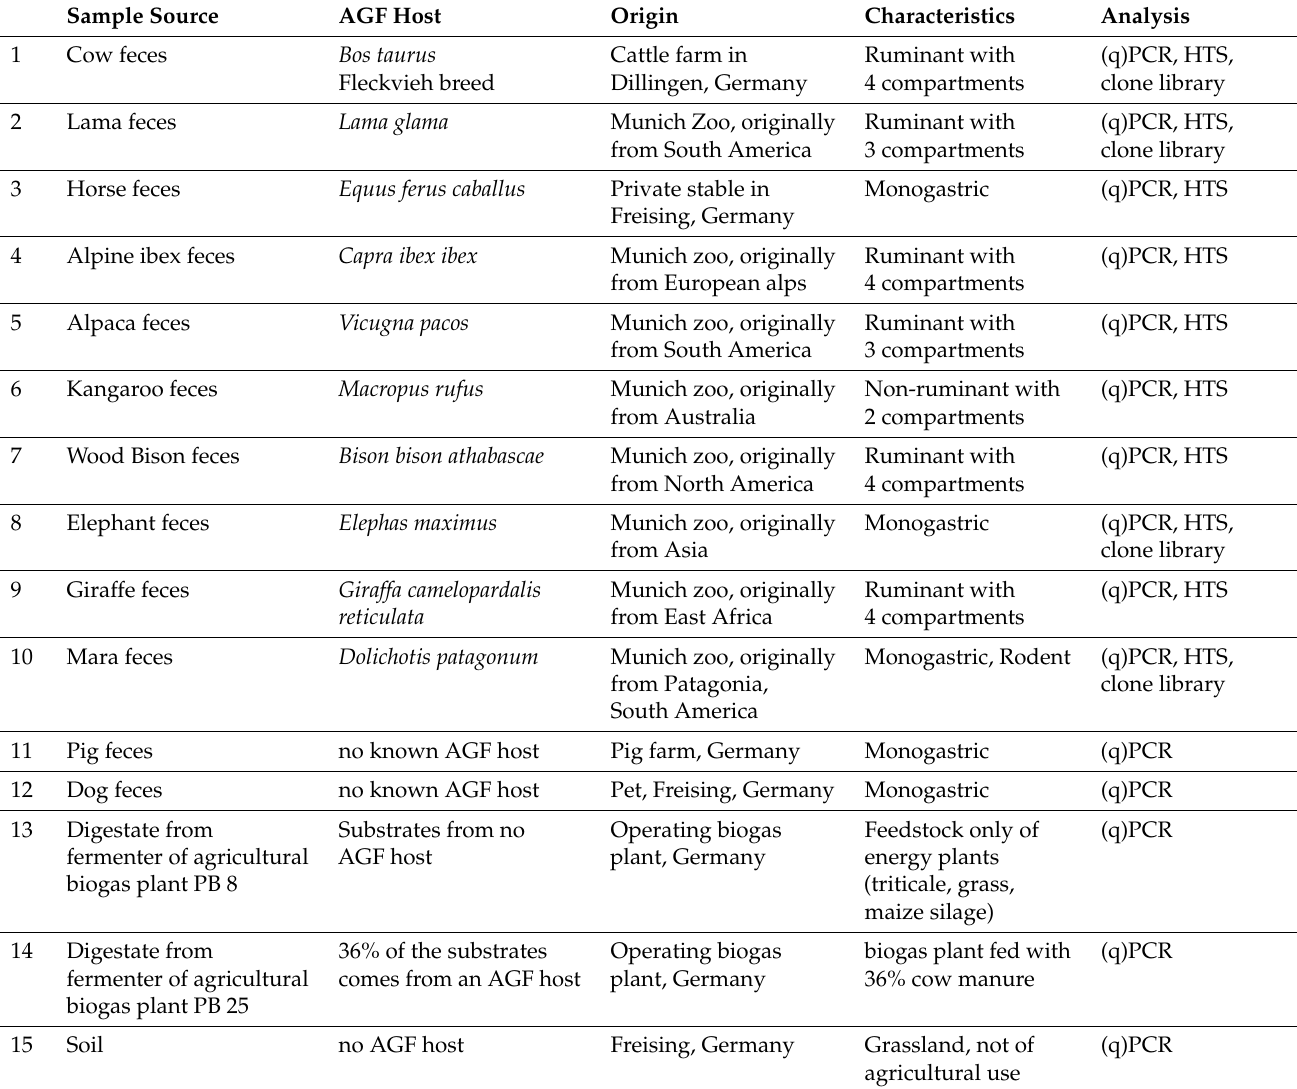
Table 2. Description of the environmental samples used to test the AGF-LSU-EnvS primer pair. HTS: high-throughput sequencing. (q)PCR: PCR based analysis, conventional or quantitative